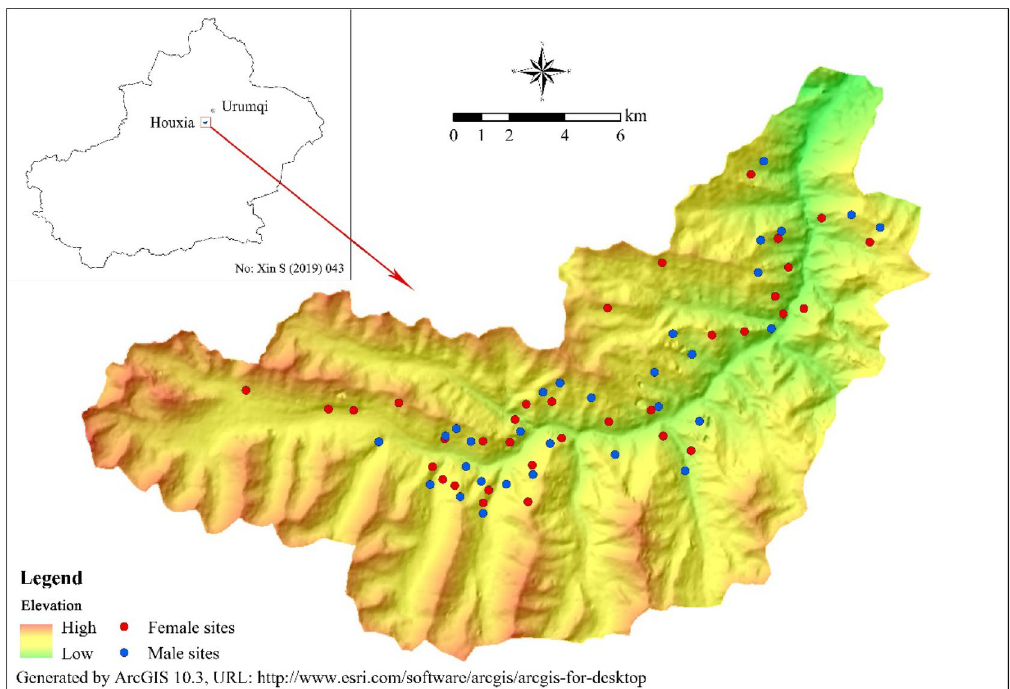
Figure 4. Study area in the Eastern TianShan Mountains, Xinjiang, China and distribution of female and male